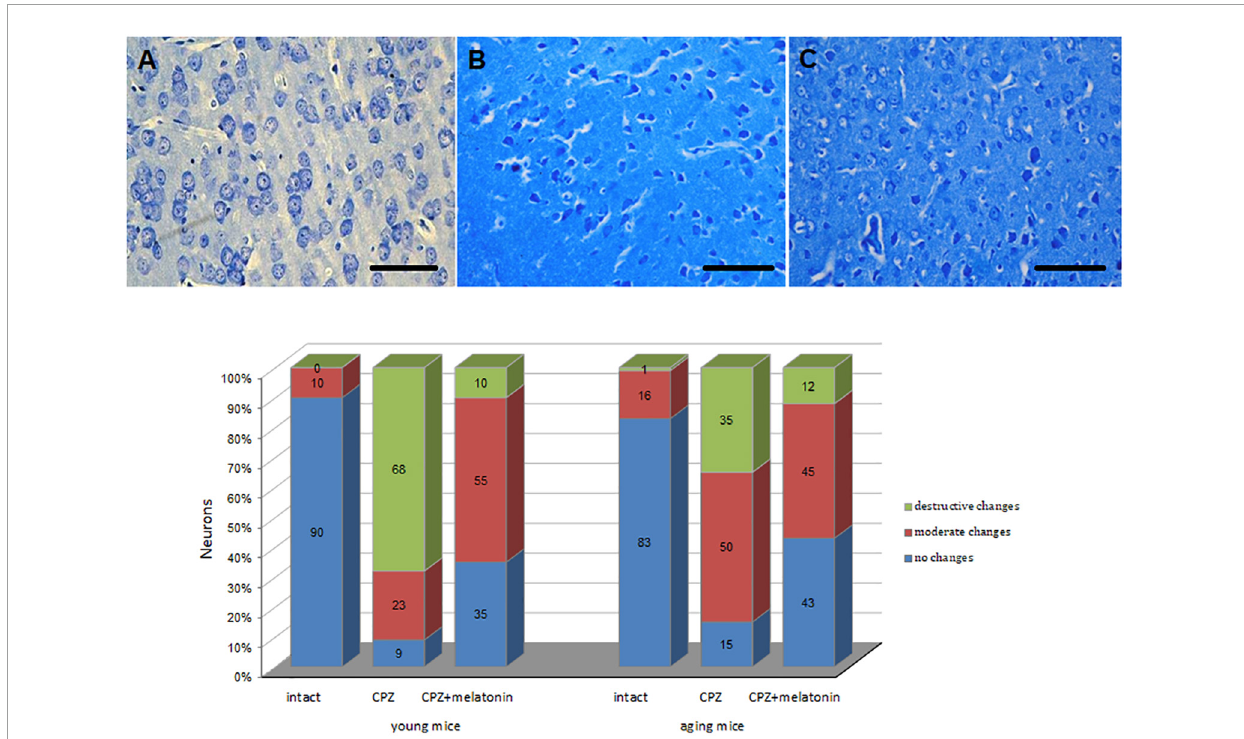
FIGURE6 Microphotographs of histological sections of cerebral cortex ( n = 10) and the percentages of different types of neurons in cerebral cortex of young and aging mice of experimental groups ( n = 5 in each group): (A) intact group; (B) cuprizone group; (C) cuprizone + melatonin group (Labunets et al., 2018b). Toluidine blue staining. Scale bar, 50 µ